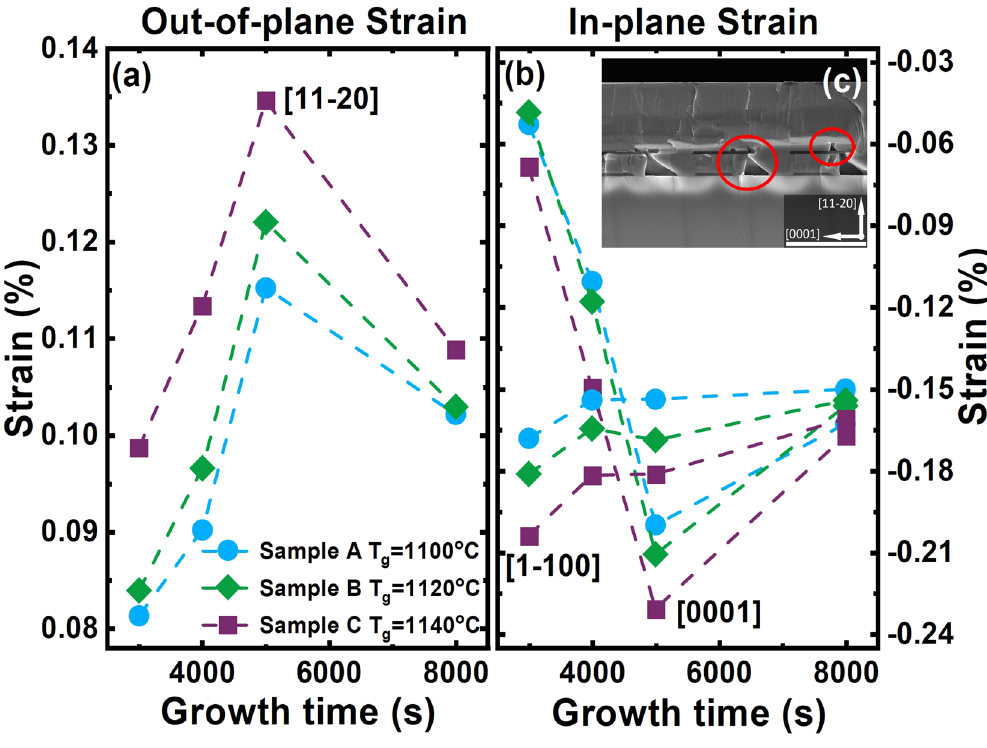
Figure 6. ( a ) Out-of-plane strain evolution of Sample A, B and C as a function of overgrowth time; ( b ) in-plane strain evolution of Sample A, B and C as a function of overgrowth time. Inset: Cross-sectional SEM image of a fully coalesced sample overgrown on our regularly arrayed micro-rod template. The red circles highlight two kinds of voids. Scale bar: 2 μ